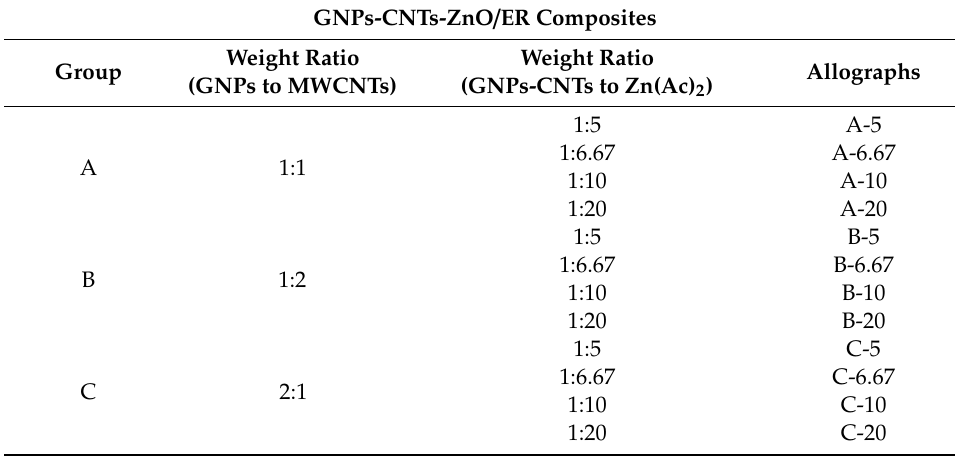
Table 1. Classification and allographs of GNPs-CNTs-ZnO/ER samples.